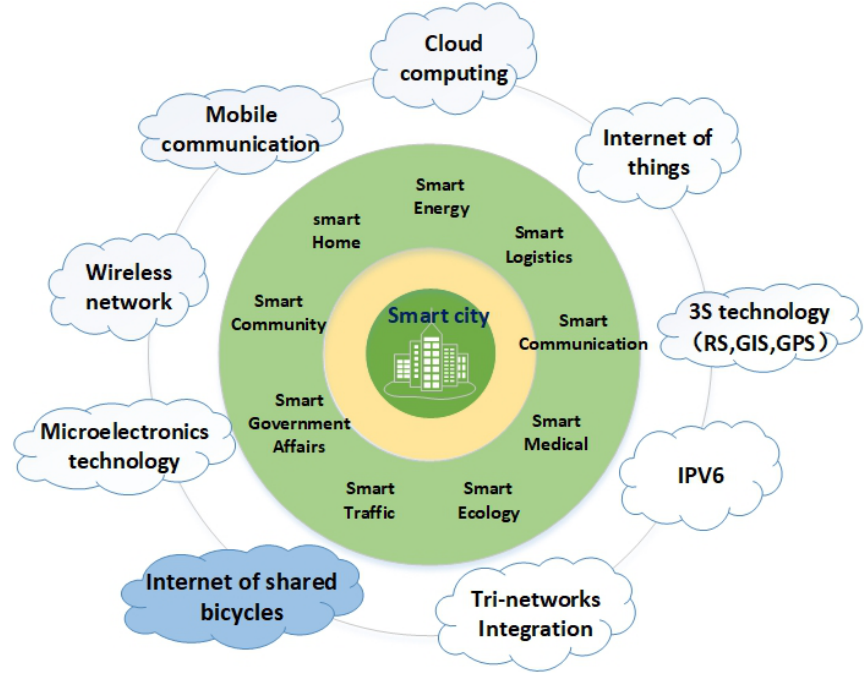
Figure 1. Smart city’s